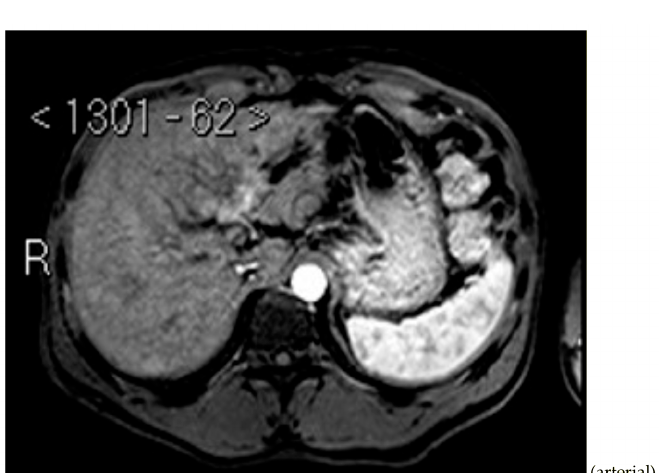
Figure 5. MRI T2. Figure 5. MRI T2.